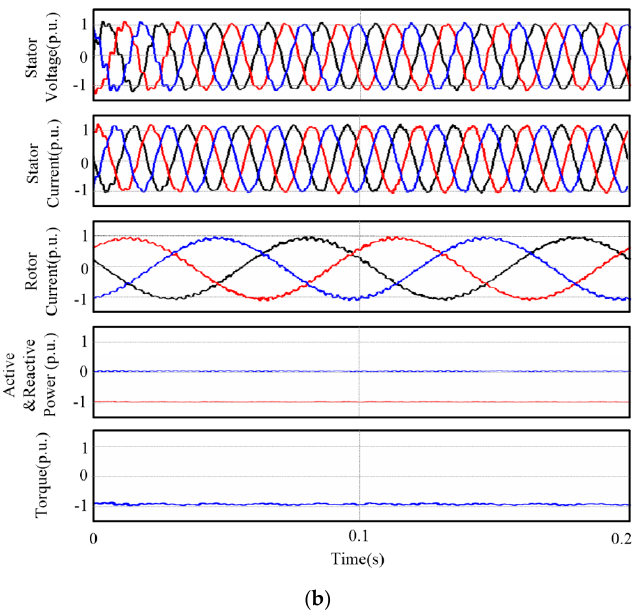
Figure 20. Simulation results of DFIG system in weak grid with Lead/Lag PLL (a) Low bandwidth; and, (b) High bandwidth.